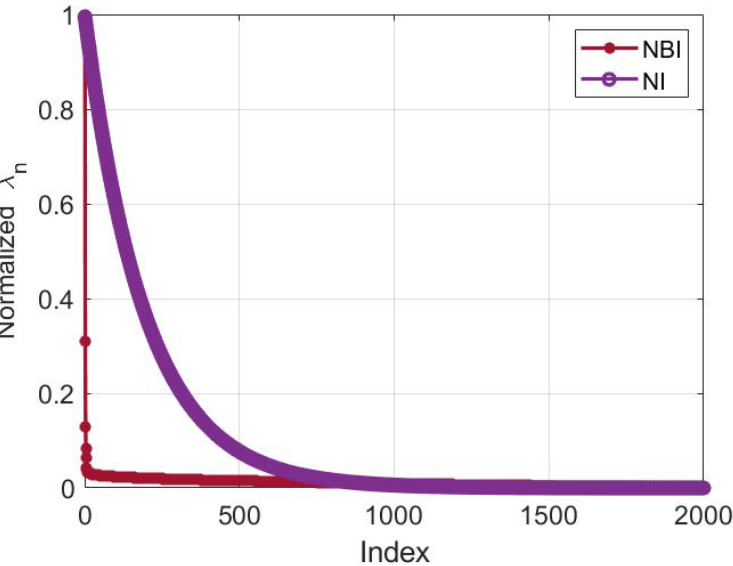
Figure 5. The positioning signal is decomposed in KL with narrow-band interference (NBI) and interference-free